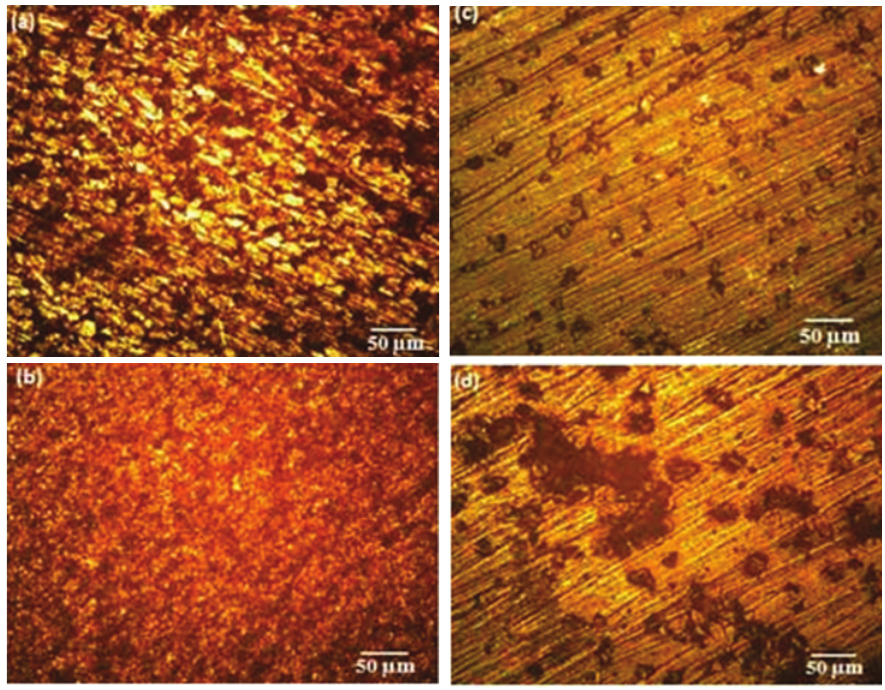
Figure 6: Optical microstructure of erosion corrosion.